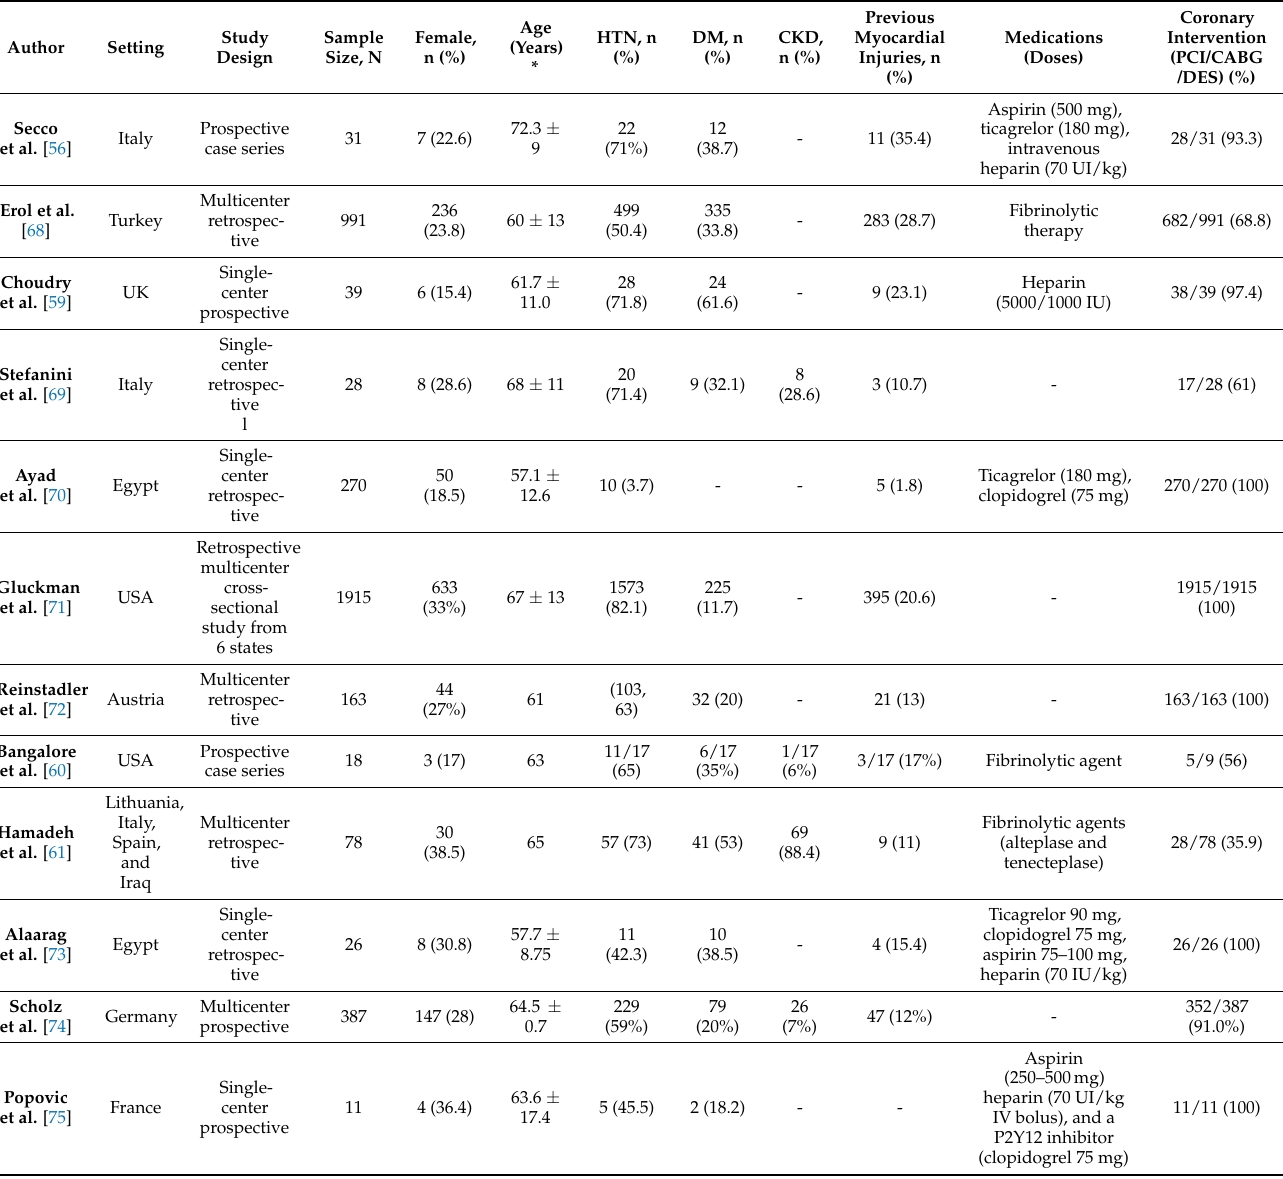
Table 1. The studies that have reported on the management of myocardial injuries among SARS-CoV-2